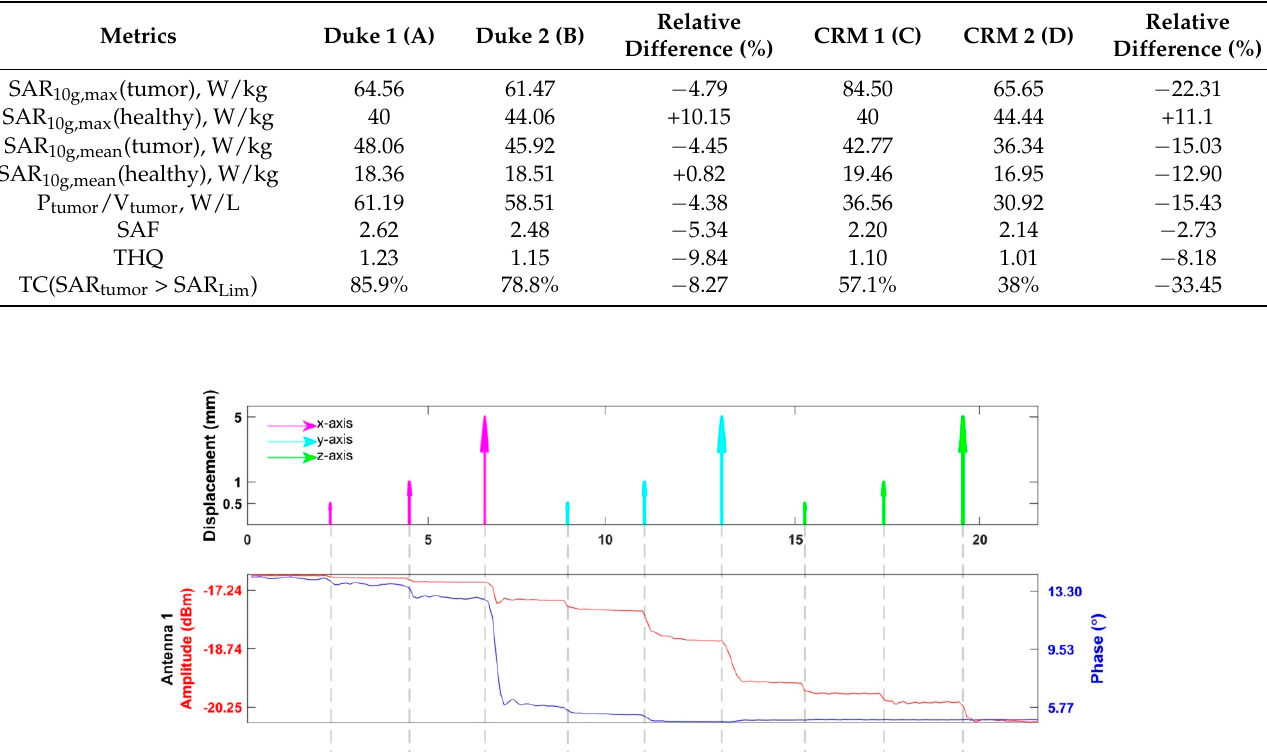
Table 1. Metrics used for the evaluation of the impact of motion on the RF heating of the Duke head model (Duke) and the CRM of the head. The Duke 1 and CRM 1 columns show the numerical results of simulations (Figure 8A,C) with the head models being placed in the center of the RF applicator. The Duke 2 and CRM 2 columns are the numerical results of simulations (Figure 8B,D) with the human head models being placed off-center (5 mm displacement upwards). SAF: SAR